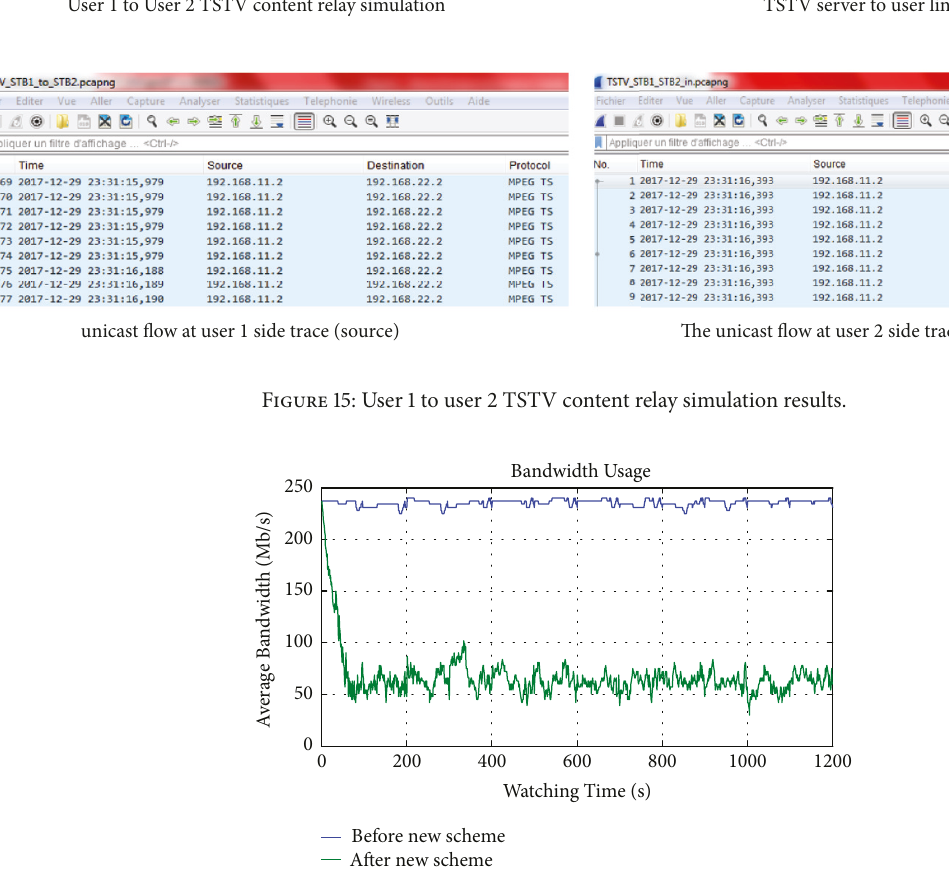
Figure 16: TSTV Bandwidth usage before and after using the new